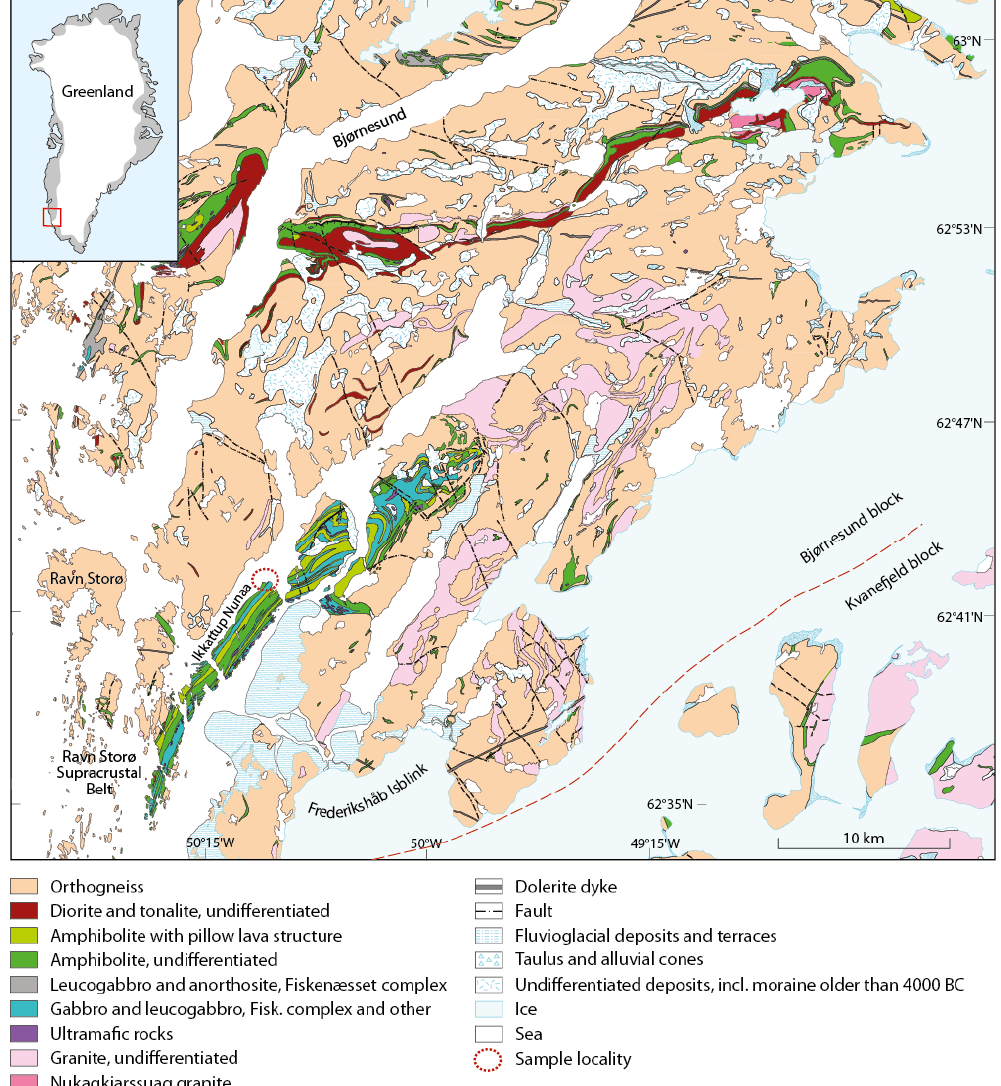
Figure 1. Geological map showing the Bjørnesund region in southern West Greenland. Sample locality, as well as the major tectonic boundary between the Bjørnesund Block and the Kvanefjeld block are indicated [12]. Map adapted from the Geological Survey of Denmark and Greenland (GEUS) [13]; reproduced with permission from GEUS.